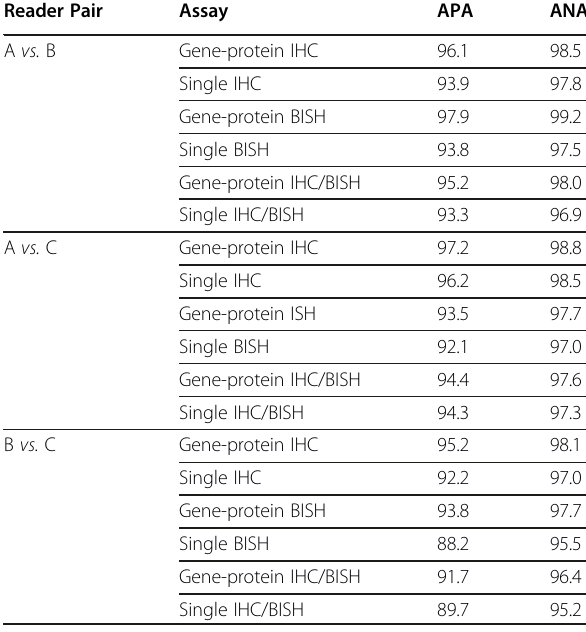
Table 7 Gene-protein IHC/BISH (comparator) vs. single IHC/BISH (reference) agreement analyses